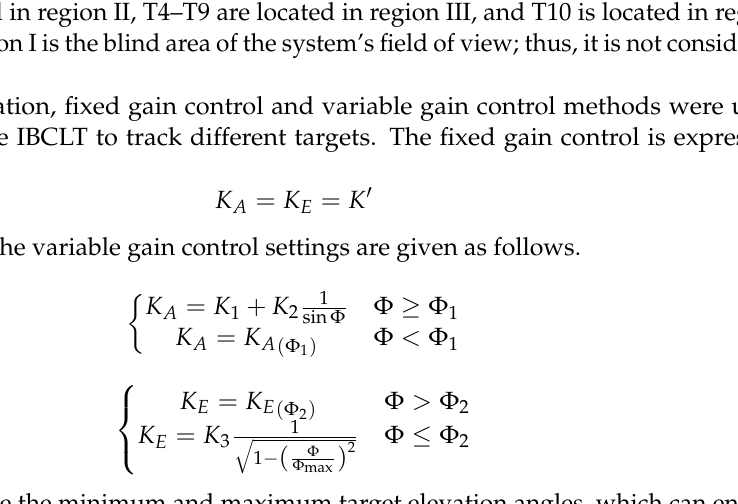
Figure 7. Different target positions.